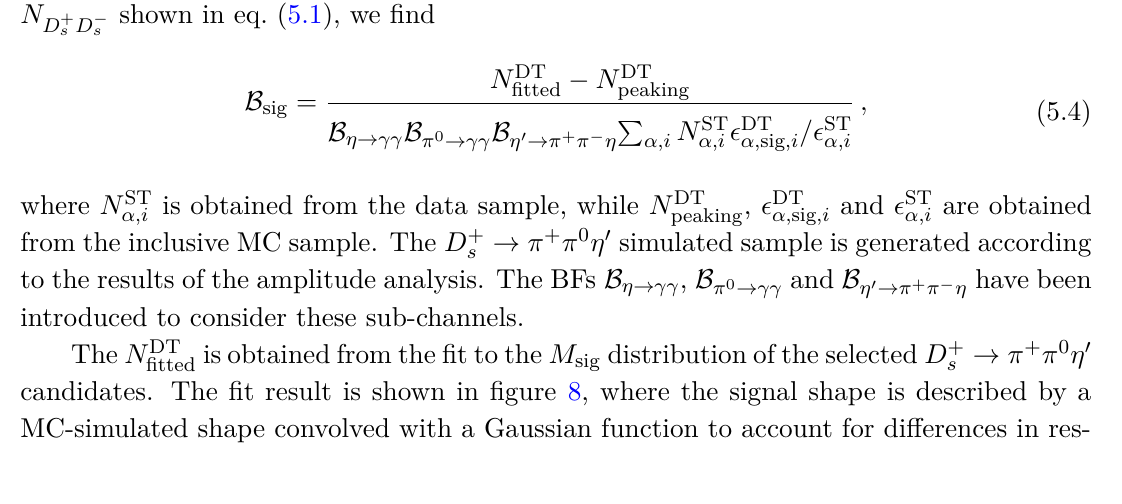
Figure 7 . Fits to the M tag distributions of the ST candidates from the data sample at 4 . 178 GeV. The points with error bars are data, the red solid lines are the total fits, and the black dashed lines are background. The pairs of red arrows denote the signal